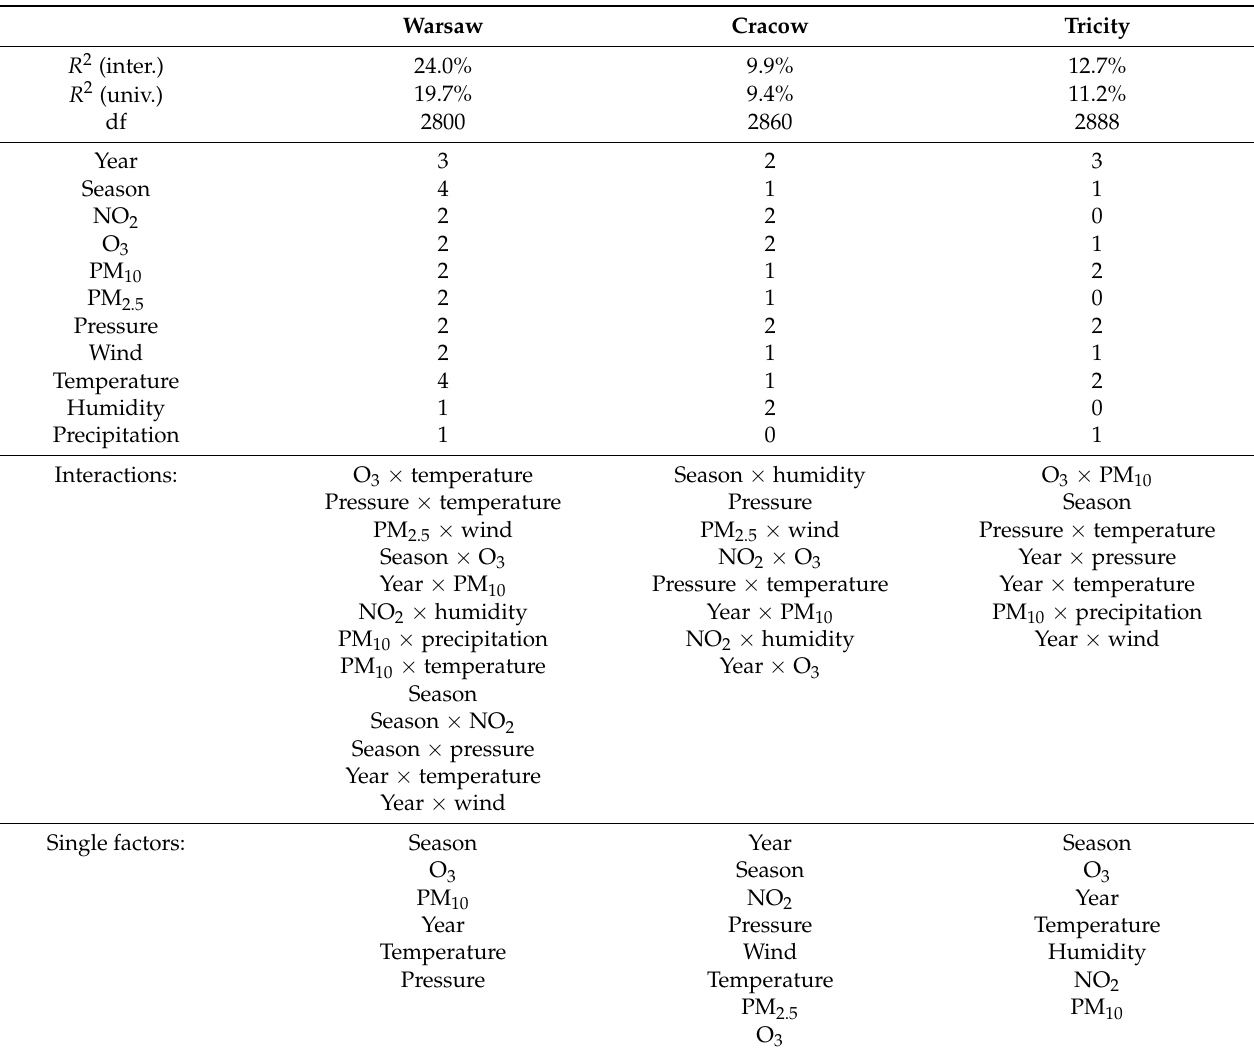
Table 3. Characteristics of the final models (with and without interactions) describing effects of air pollutants and weather conditions on the number of all-cause deaths. Warsaw Cracow